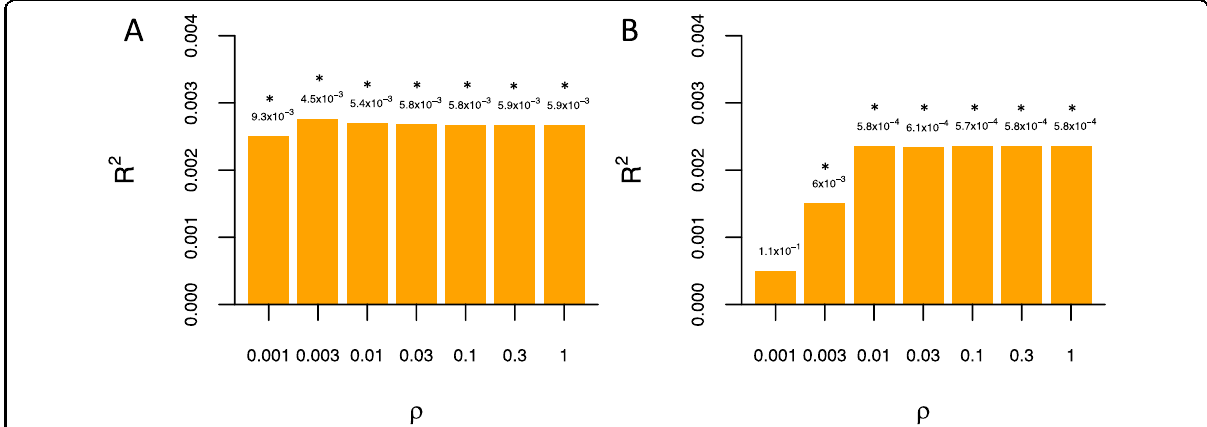
Fig. 4 OC traits in the community and OCD share polygenic risk. A Variance explained ( R 2 ) in OCD case/control status in replication samples by polygenic risk for OC traits from Spit for Science B variance explained in OC traits in Spit for Science sample by polygenic risk for OCD from replication samples across a range of prior proportion of causal variants ( ρ ). Analyses conducted using LDpred. * p <